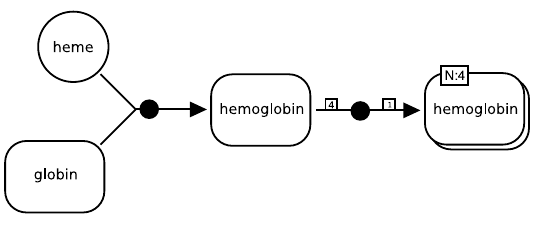
Figure 2.37: Formation of